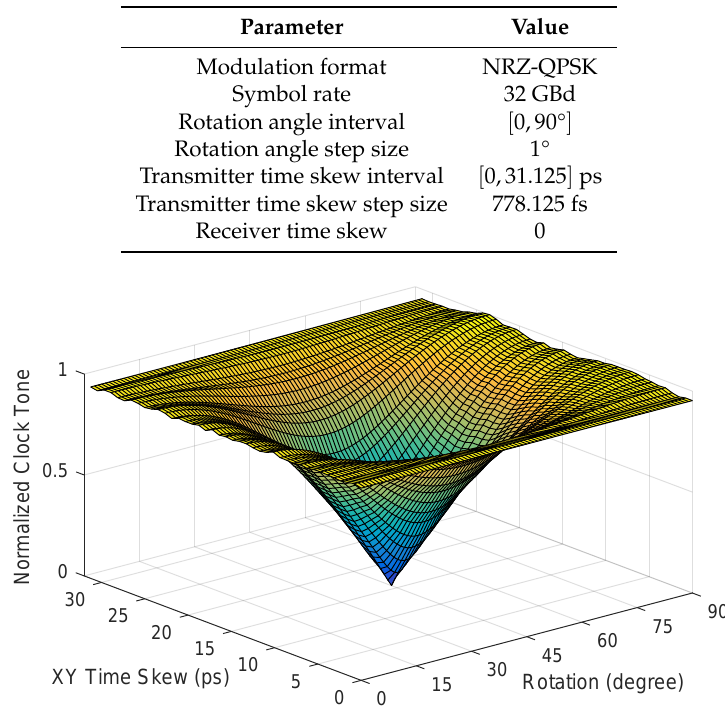
Figure 4. Normalized clock tone amplitude as function of rotation angle and transmitter-side inter-polarization time